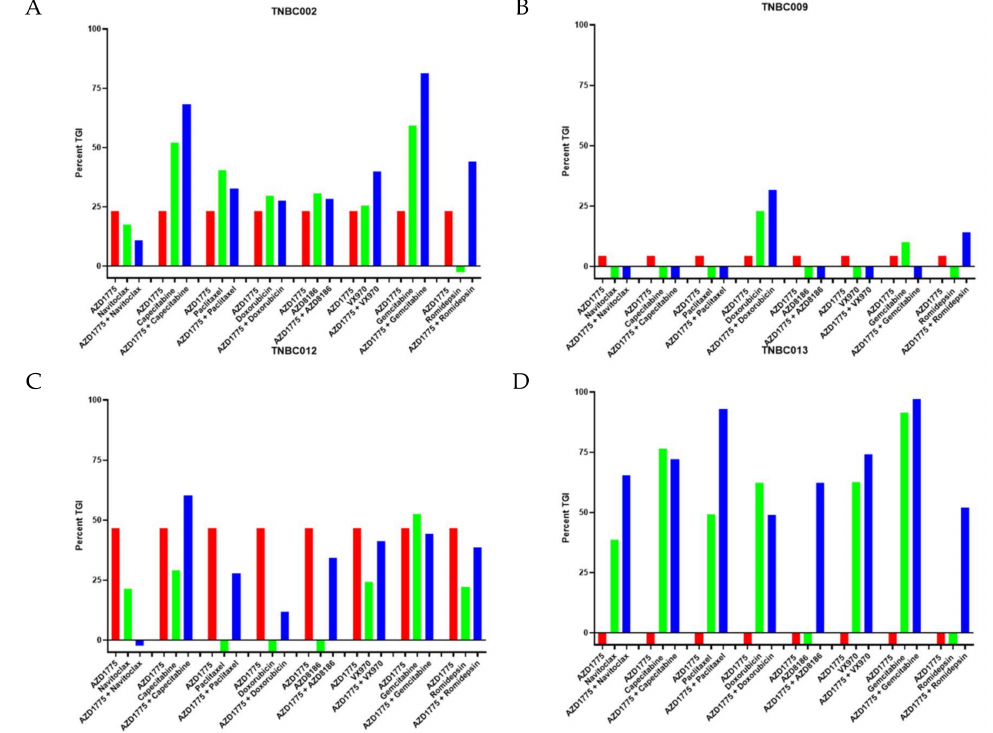
Figure 1. E ff ect of AZD1775 alone or in combination with chemotherapy or targeted agents in triple-negative breast cancer (TNBC) PDX models. Percent tumor growth inhibition (TGI) was calculated for each model ( n = 3 animal / group). AZD1775, 50 mg / kg (PO, QD); paclitaxel, 15 mg / kg (IP, QW); capecitabine, 60 mg / kg (PO, QWx2); doxorubicin, 1.5 mg / kg (IP, QW); AZD8186, 25 mg / kg (IP, QD); navitoclax 100 mg / kg (PO QWx3); romidepsin 1.34 mg / kg (IP, QW); VX970, 40 mg / kg (IP, QW); gemcitabine 40 mg / kg (IP, QW). ( A ) TNBC002, ( B ) TNBC009, ( C ) TNBC012, and ( D )